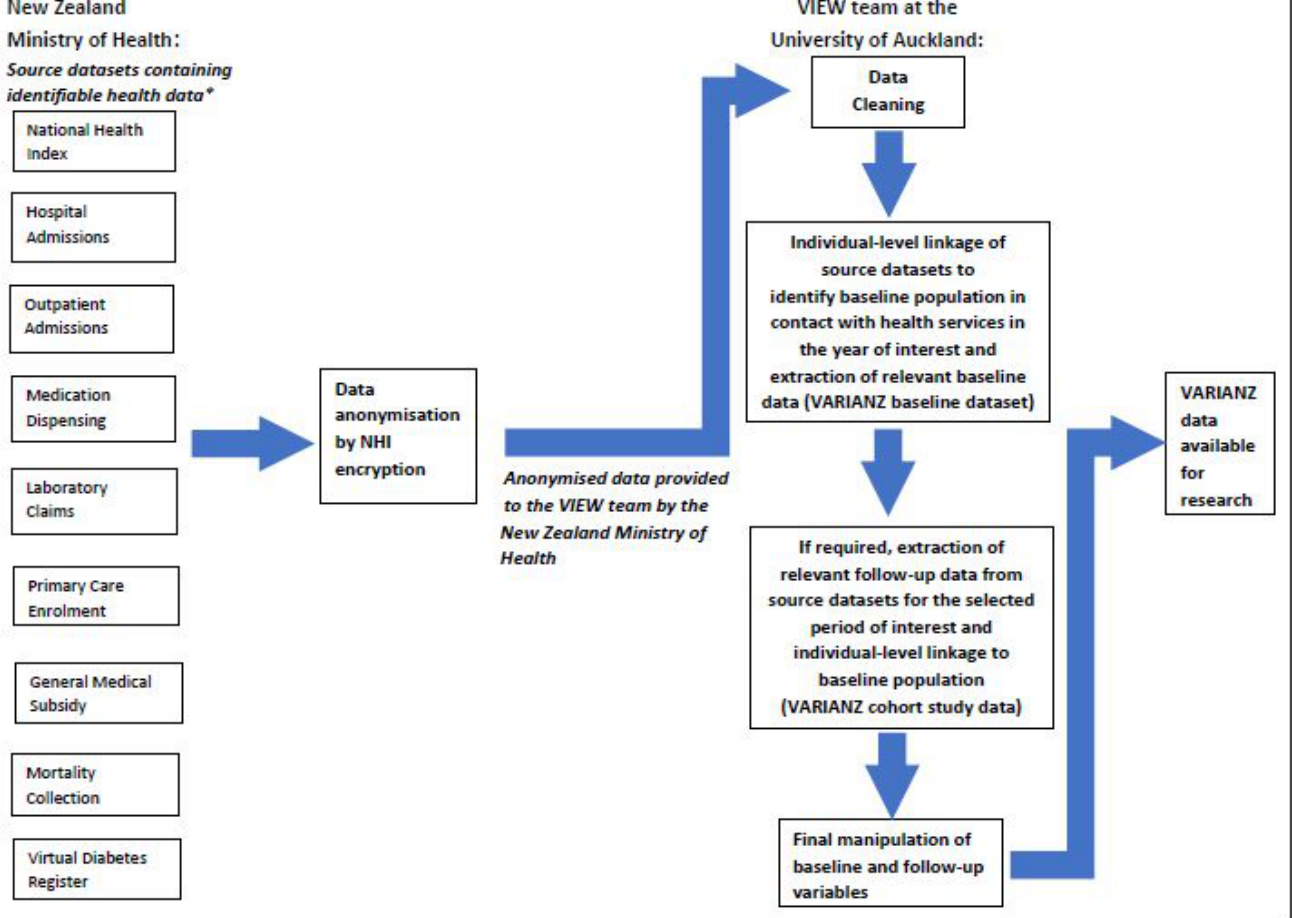
*The first eight source datasets are used to identify the full baseline VARIANZ population for a given time period. The Virtual Diabetes Register is used to determine diabetes status at baseline (or during follow-up if required), but does not identify any additional individuals at baseline as it draws on selected data from five of the other datasets. The Virtual Diabetes Register is, therefore, not included in the linkage process to identify the full baseline population. Subsets of the full VARIANZ baseline datasets based on specific health contacts can be identified from the relevant source datasets, and linked to follow-up data if